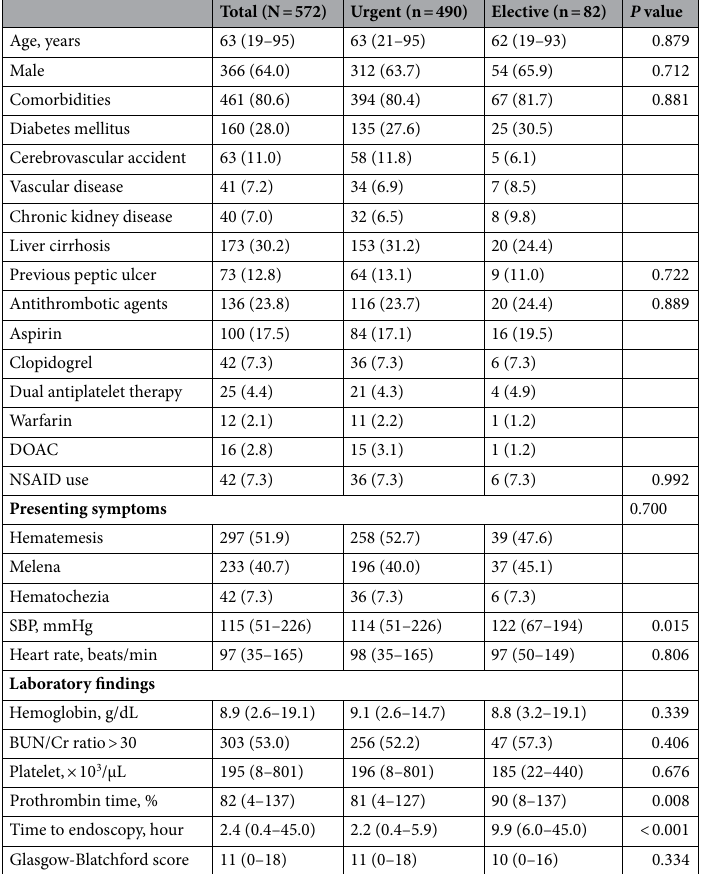
Table 1. Characteristics of the study population. Data are shown as median (range) or number (%). BUN/Cr ratio ratio of blood urea nitrogen to creatinine, DOAC direct oral anticoagulant, NSAID non-steroidal anti- inflammatory drug, SBP systolic blood pressure.